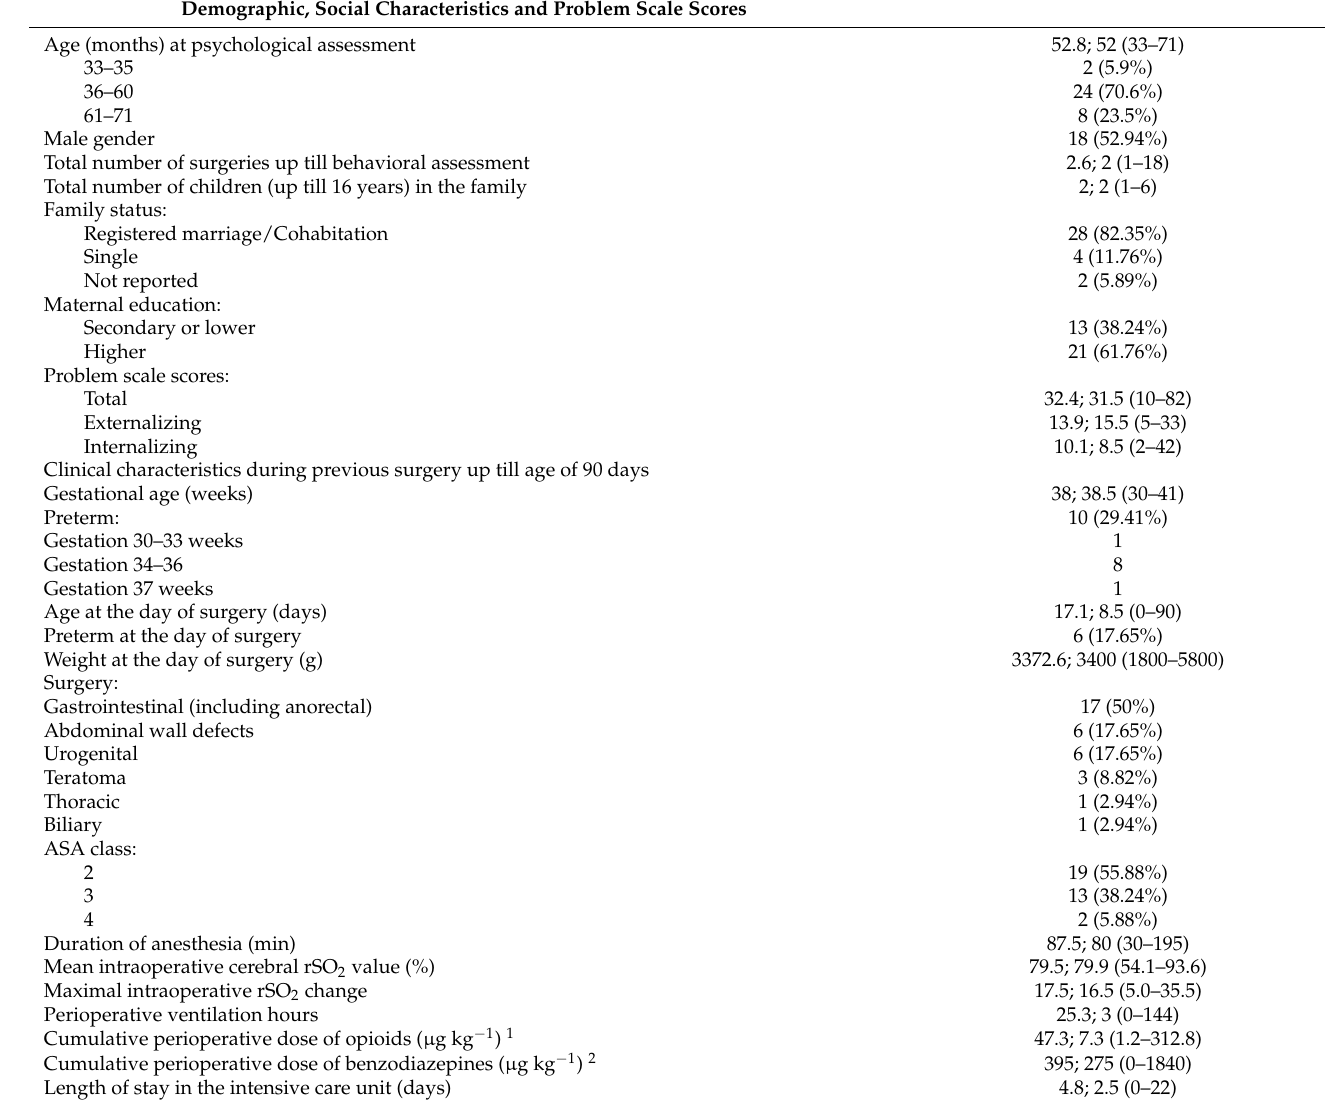
Table 1. Socio-demographic characteristics, problem scale scores assessed by Child Behavior Checklist for Ages 1 1 (CBCL/1 1 –5) and clinical characteristics of studied patients during previous surgery up till age of 90 days ( n = 34). Values 2 are mean; median (range) or number of patients